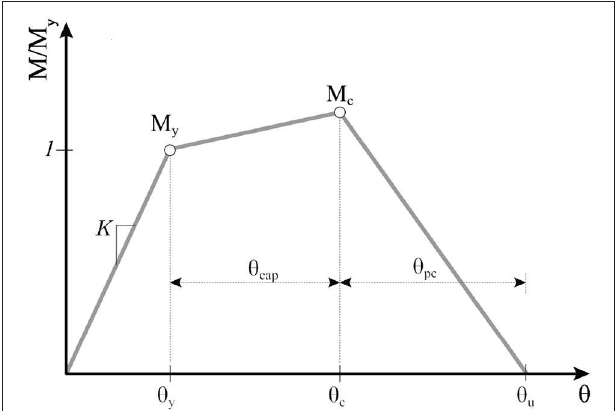
FIGURE 1 | Ibarra et al. (2005)